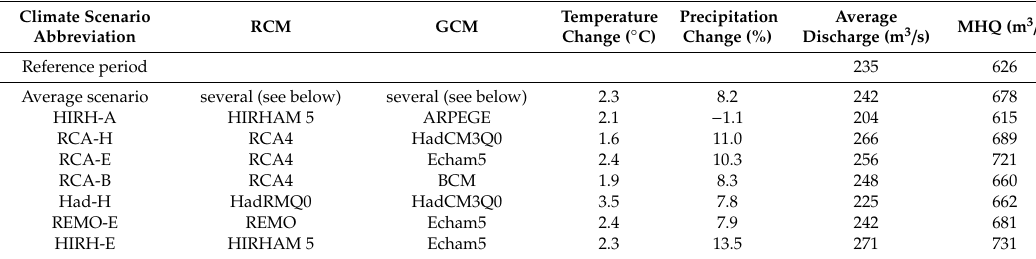
Table 2. Climate scenarios used and their change in temperature and precipitation from 1985–2014 to 2050–2079 and the simulated average discharge and MHQ in 2050–2079. Dubrovin et al. [51] also applied these values, even though they did not provide the details in their report. The first part of a climate scenario abbreviation describes the regional climate model and the latter part the global climate model, used in the